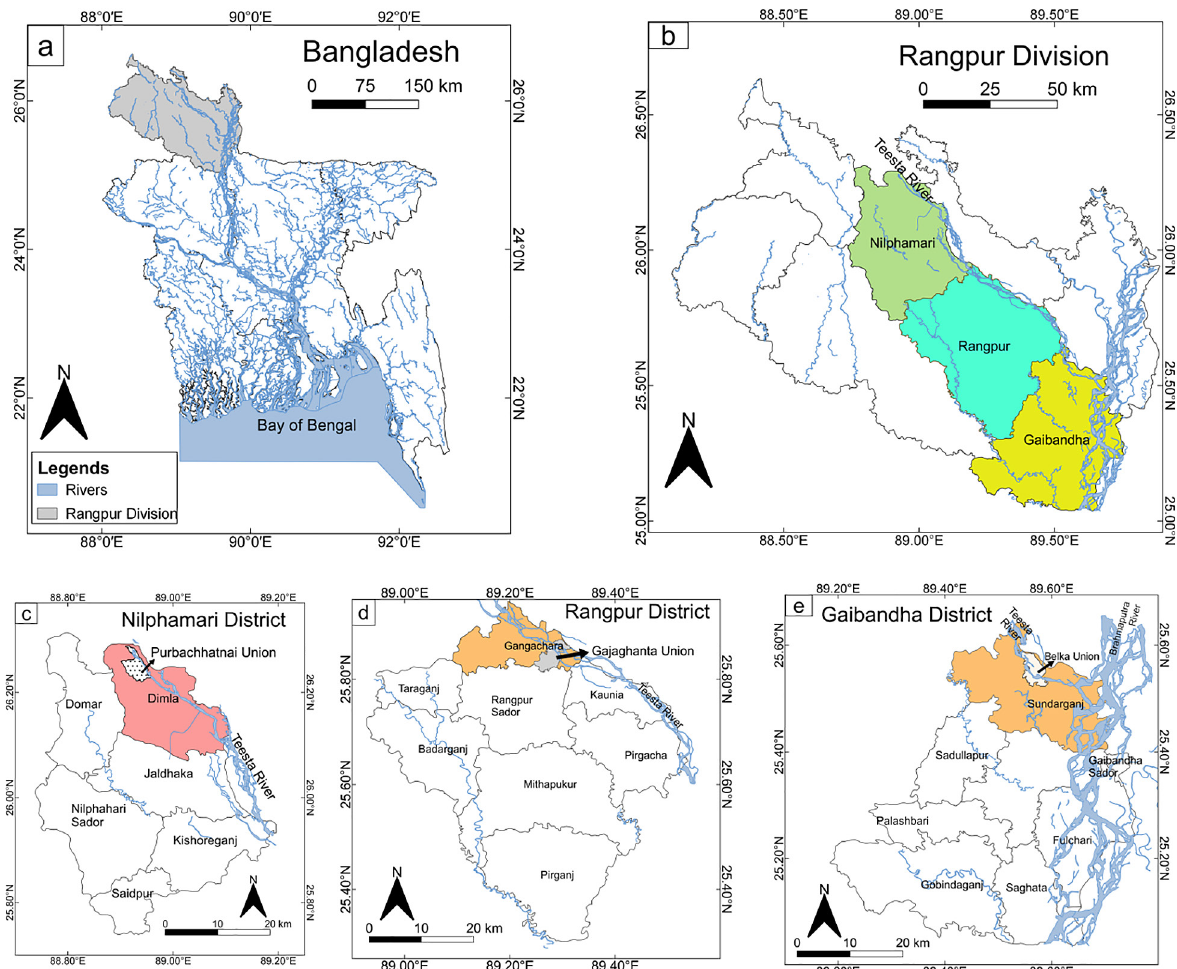
Fig. 1. Map of the study